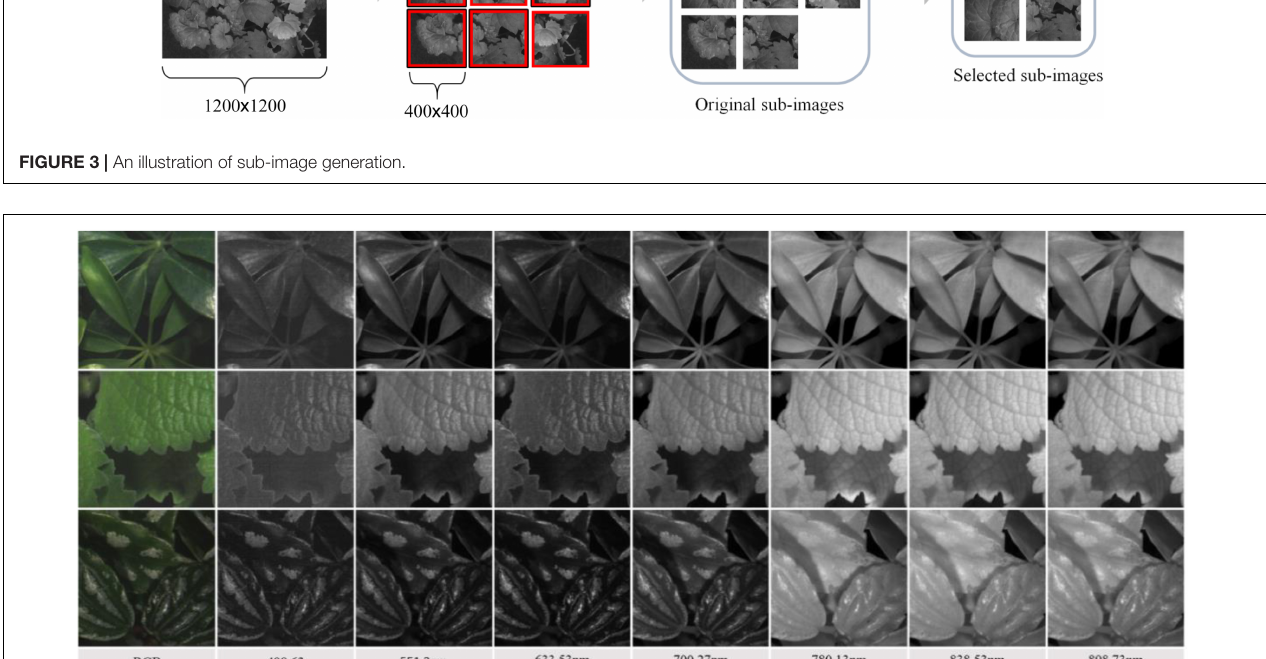
FIGURE 4 | Examples of the reflectance sub-images of plant species (Top: S.a, #11; Middle: P.am, #21; Bottom: P.c, #29) at some selected wavelengths in the visible-NIR region.